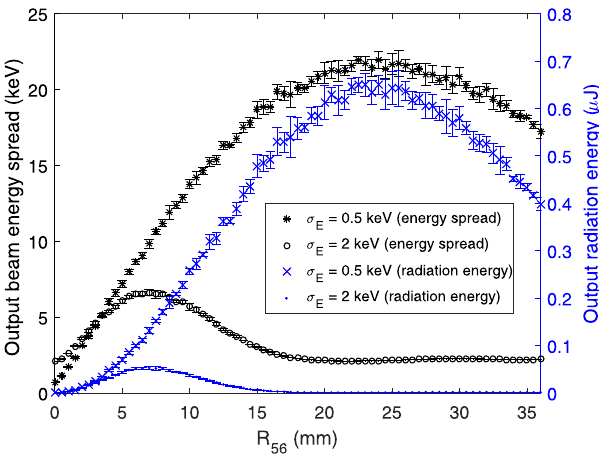
FIG. 3. Simulated induced beam energy spread (black, left axis) and radiation energy (blue, right axis) as a function of the chicane ’ s R 56 for initial beam energy spreads of 0.5 keV and 2